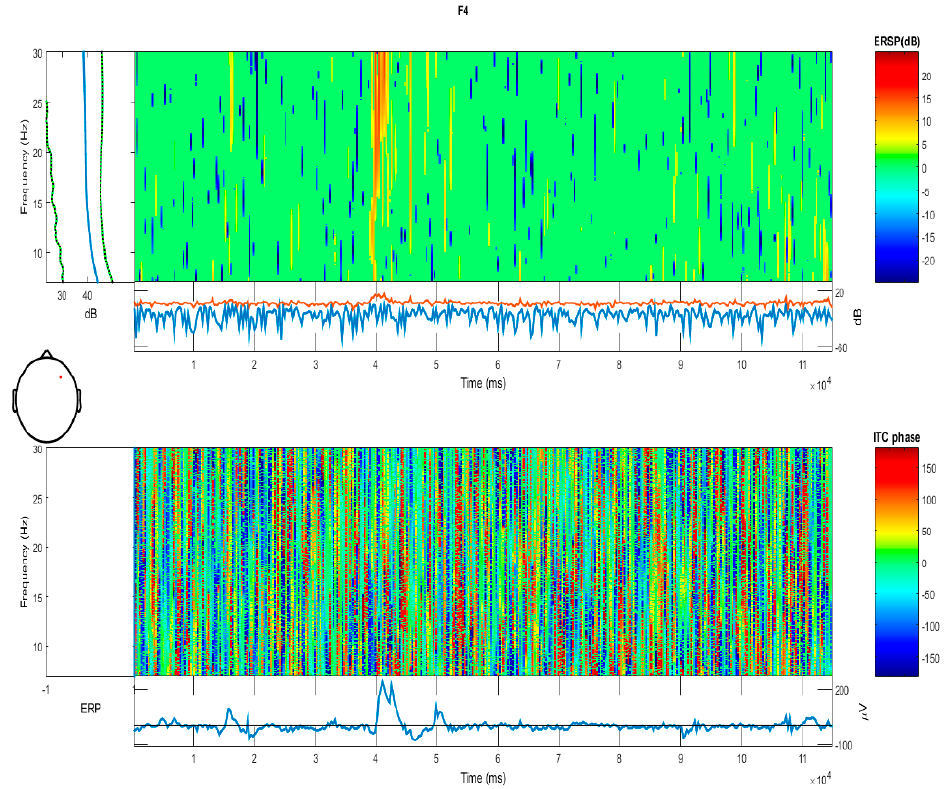
Figure 7. Brain activity of User A at point F4.